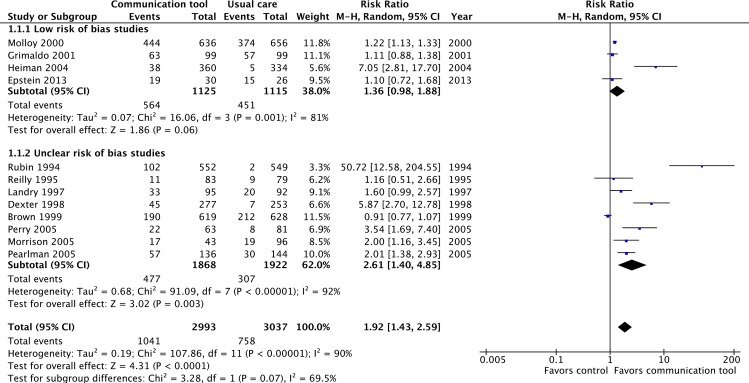
Proportion of patients with documented advance care planning.